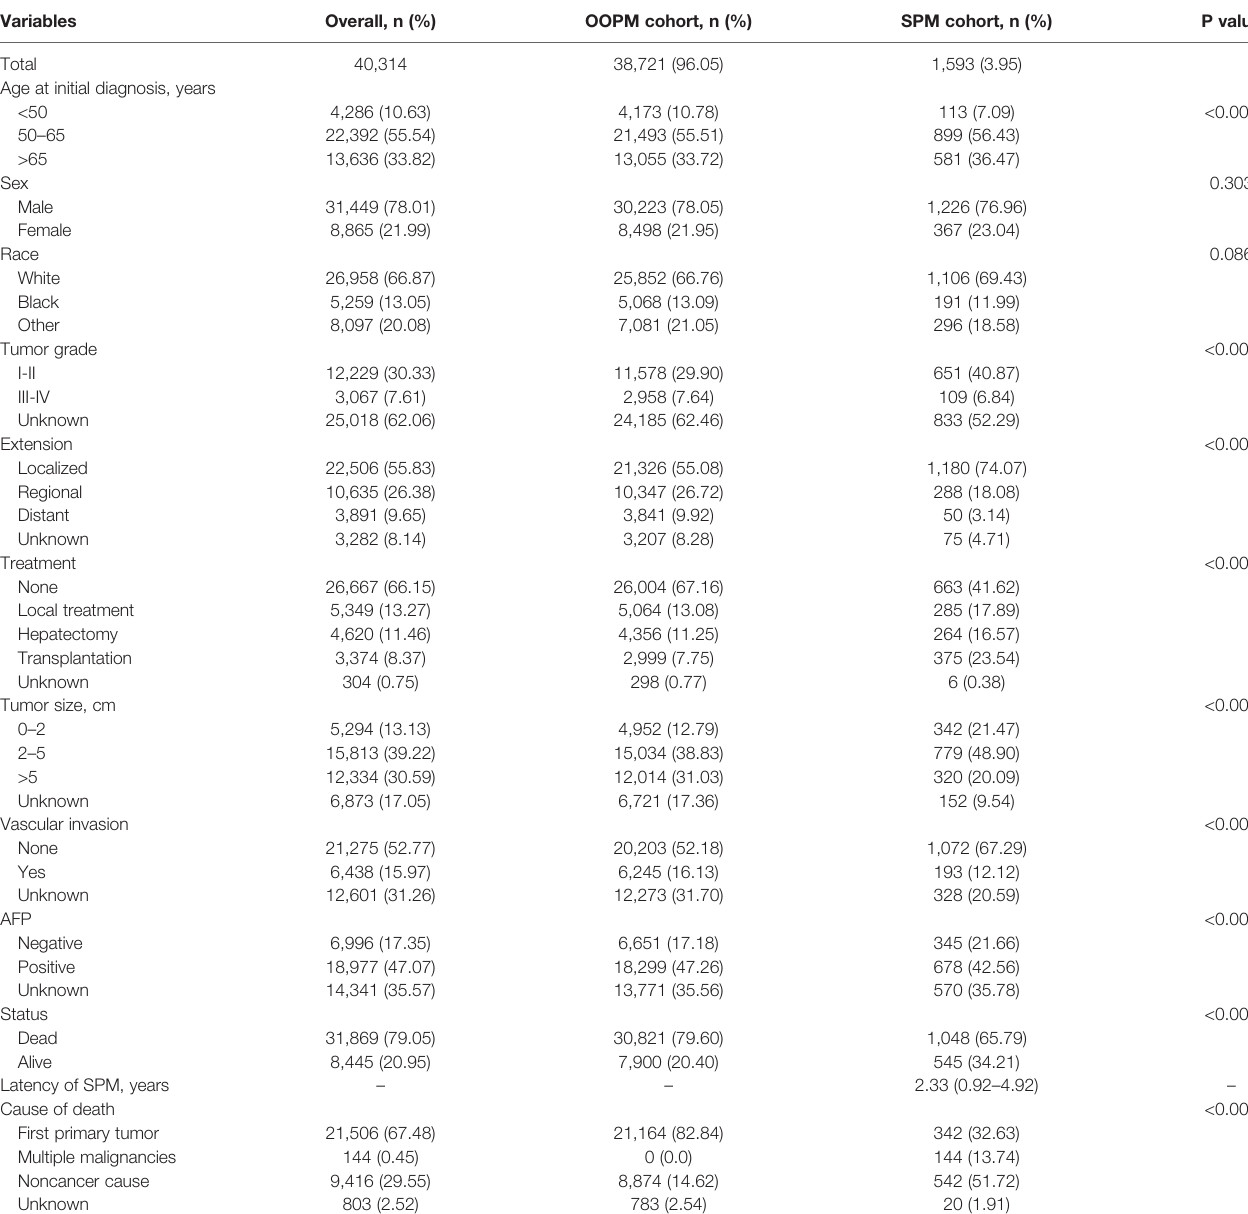
TABLE 1 | Clinicopathological characteristics of patients with HCC with and without SPMs. Variables Overall, n (%) OOPM cohort, n (%) SPM cohort, n (%) P value